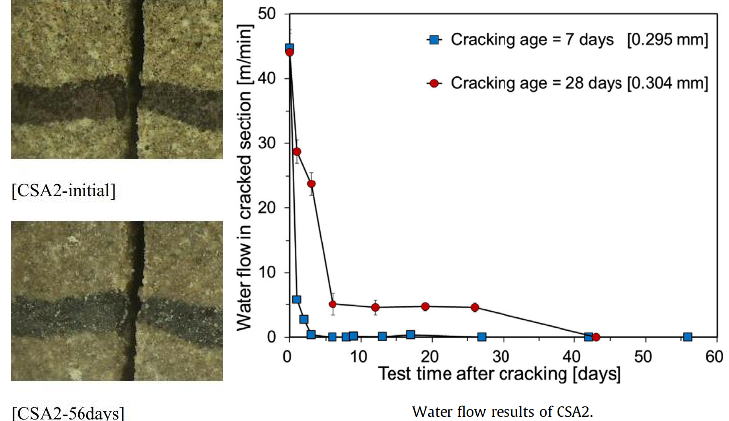
Figure 10. Crack width and water flow of specimens mixed with CA, CSA, and basic magnesium carbonate. Reprint with the permission from ref. [38]. Copyright 2022 Elsevier.